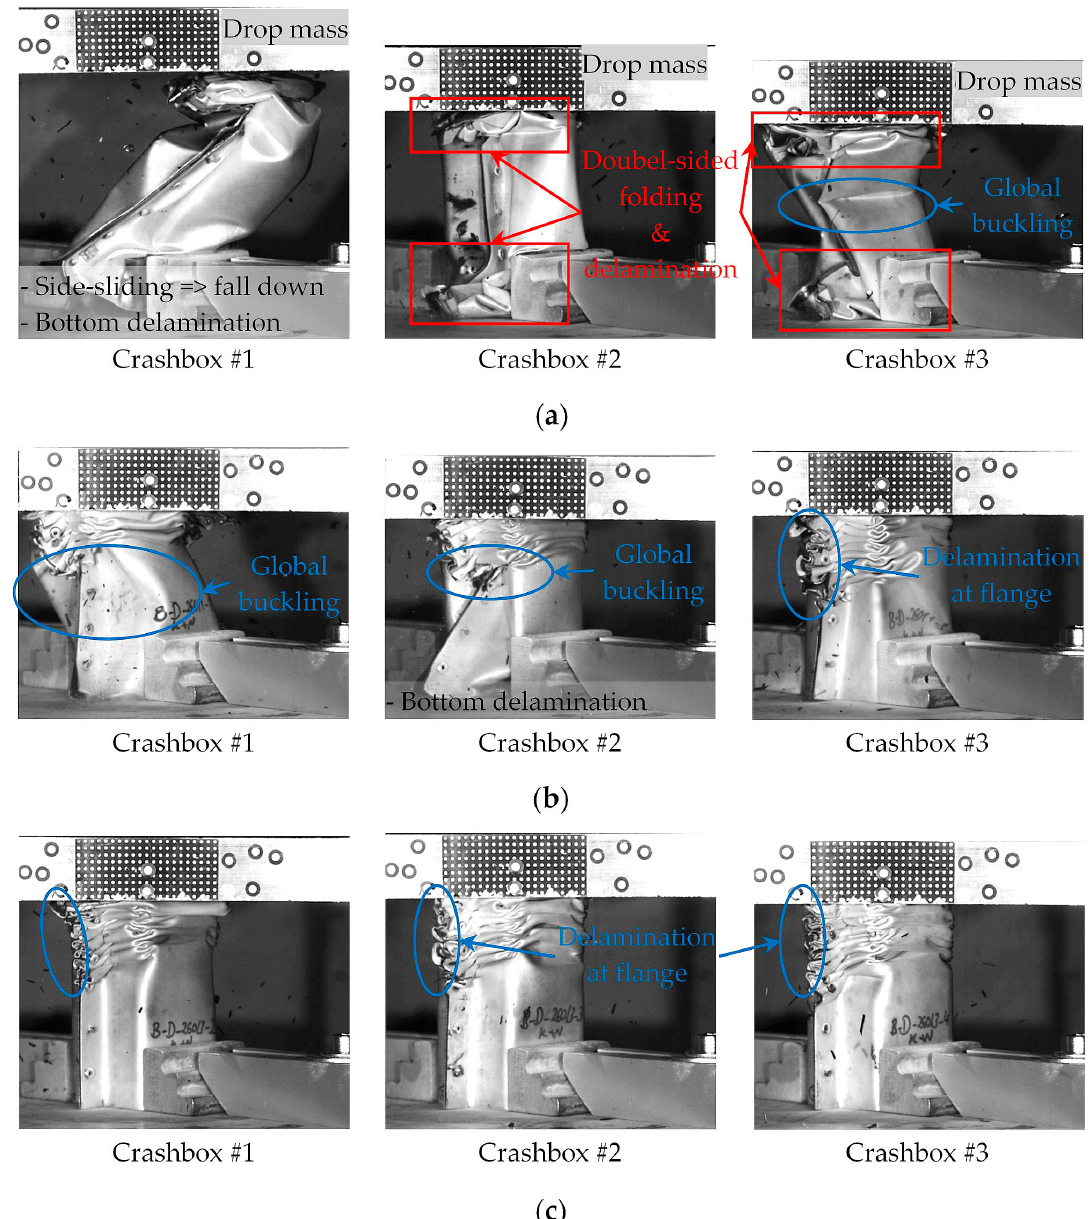
Figure 6. Failure modes of the dynamic axial crushing test of the double-hat crashboxes ( a ) without, ( b ) with weak, and ( c ) with strong adhesion strength. Three crashboxes per condition are depicted at the end of the crushing test. From the axial crushing results, it can be stated that, although the value of the adhe- sion strength in the case of weak adhesion (5.2 MPa) is about 50% of the strong adhesion (10.7 MPa), the difference in the crushing behavior, including the forming forces and dis-